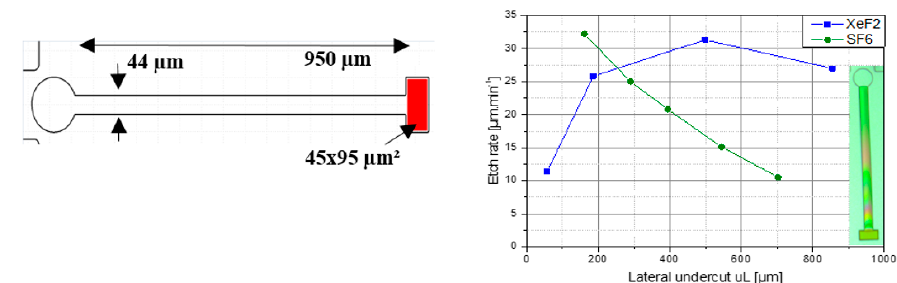
Figure 5. Etching results for same structure of the both etching gases SF 6 and XeF 2 in different etching